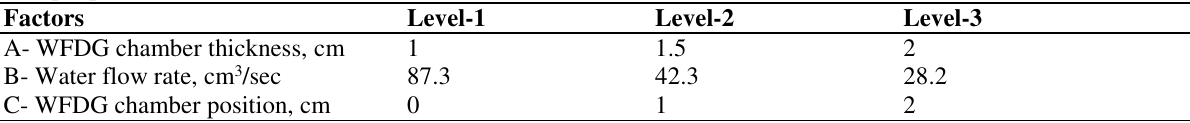
The proposed factors and levels .